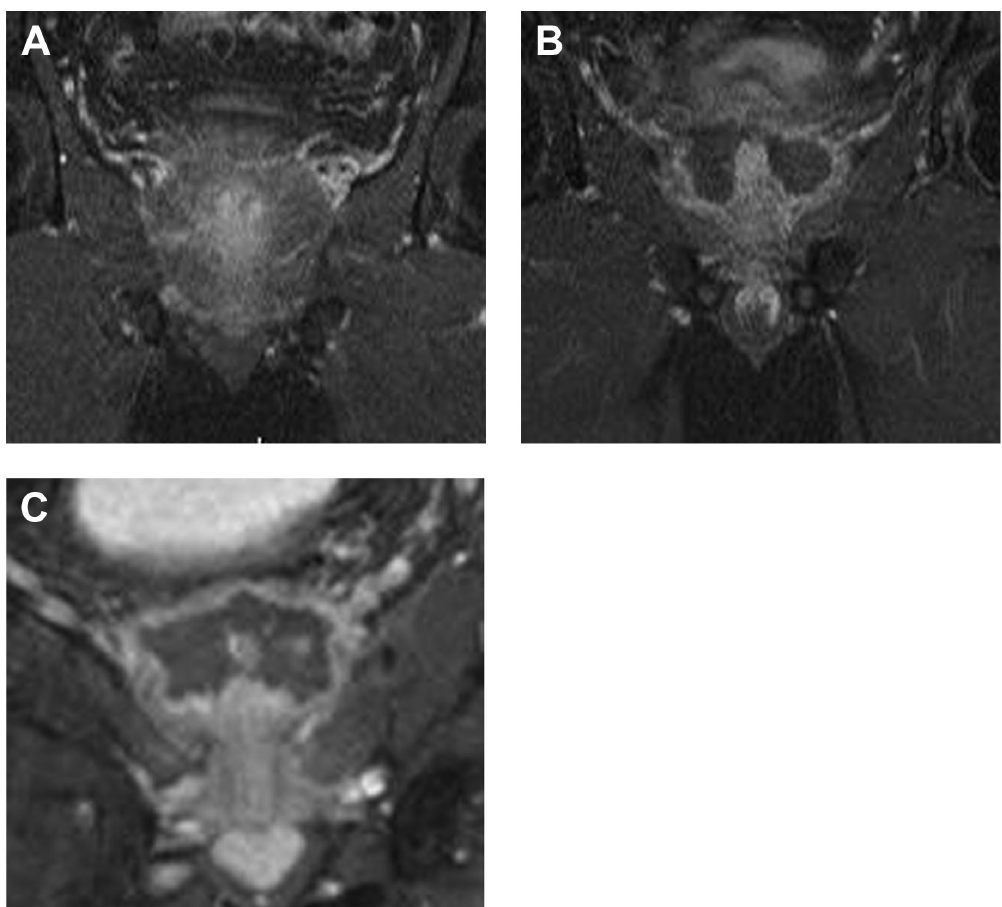
FIGURE 3. Pre- (A) and post-treatment (B, C) coronal MRIs of coalesced lesions as a continuous gadolinium defect around bladder neck and mid